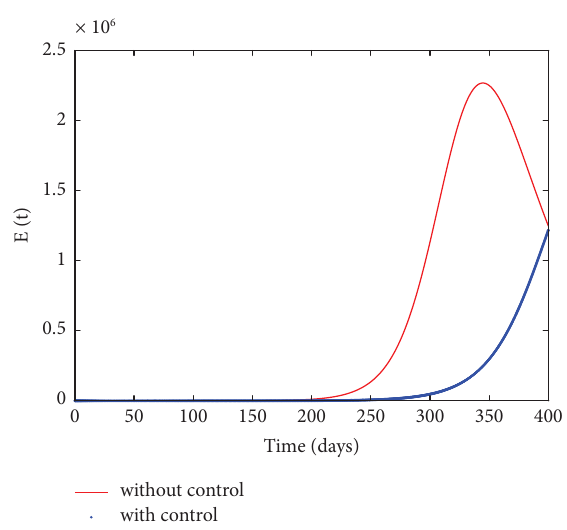
Figure 10: Behaviour of the exposed individuals with and without the optimal control.